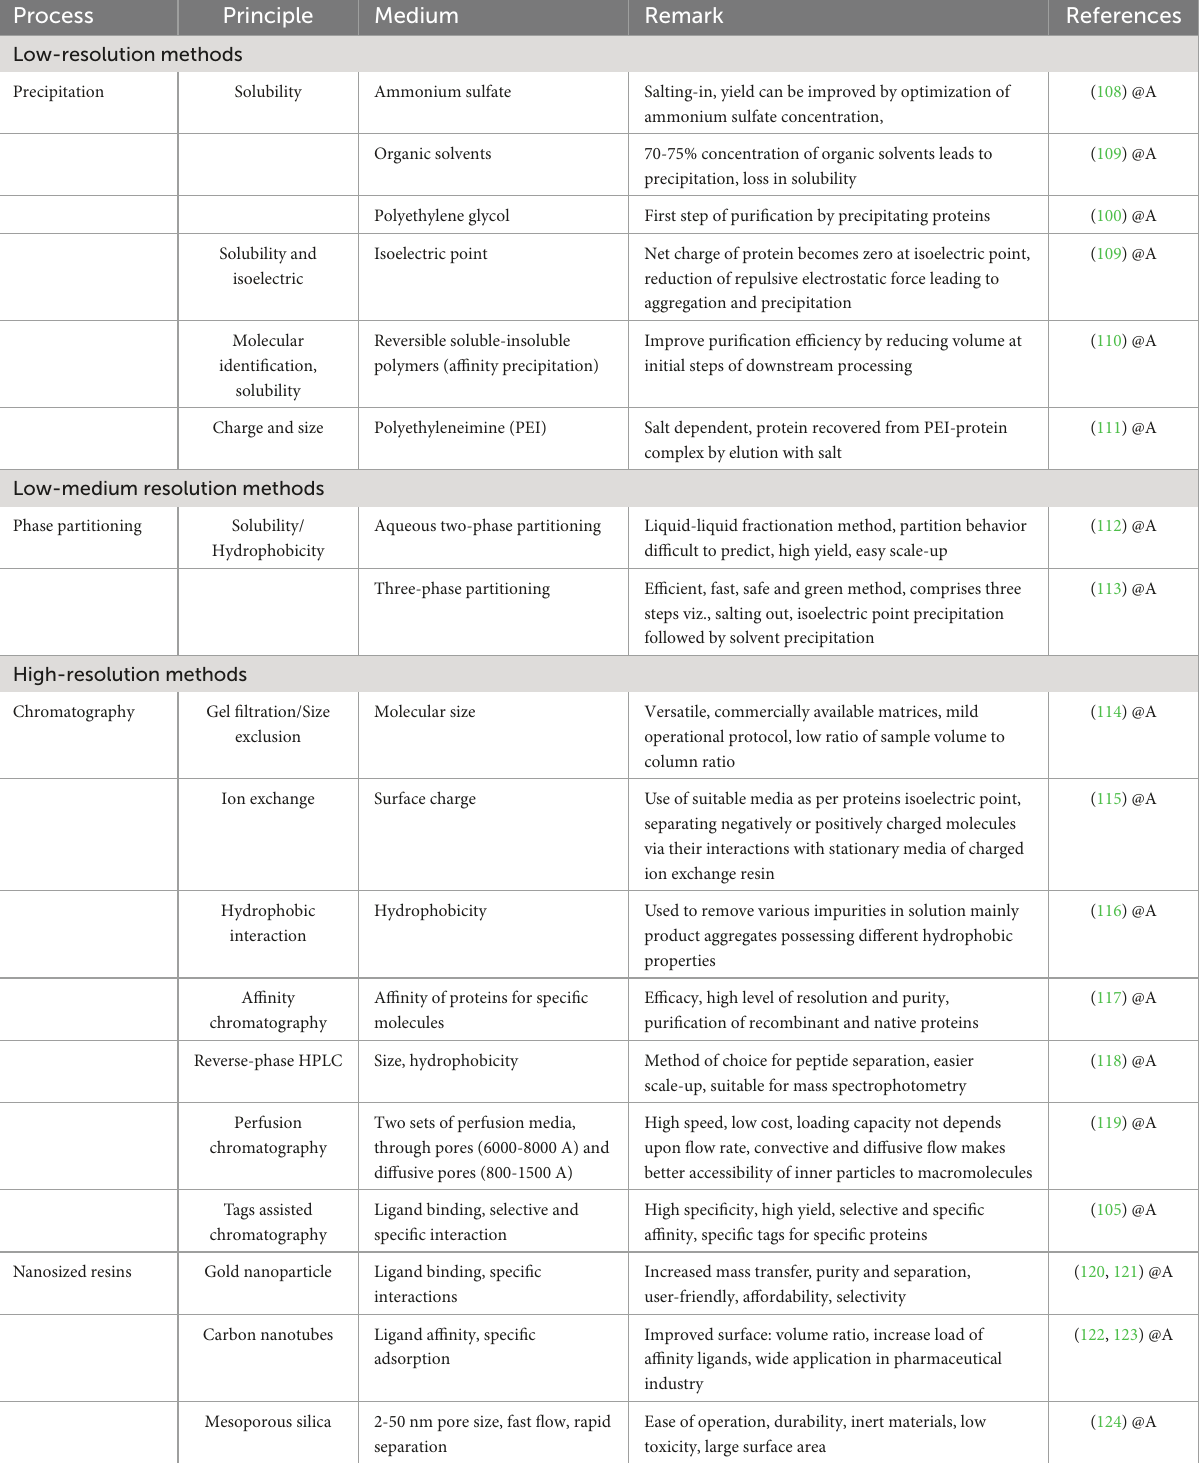
TABLE 2 Various methods of protein